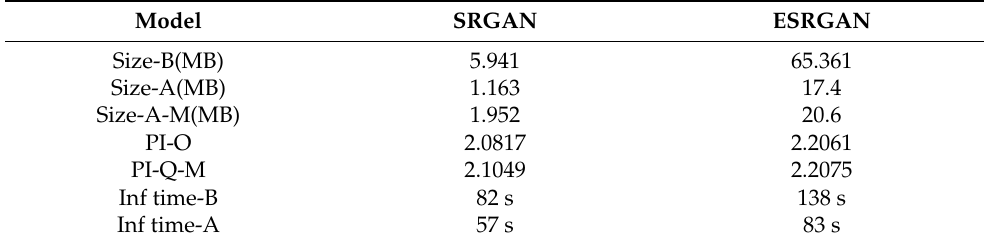
Table 3. Multi-precision quantized results of ESRGAN and SRGAN